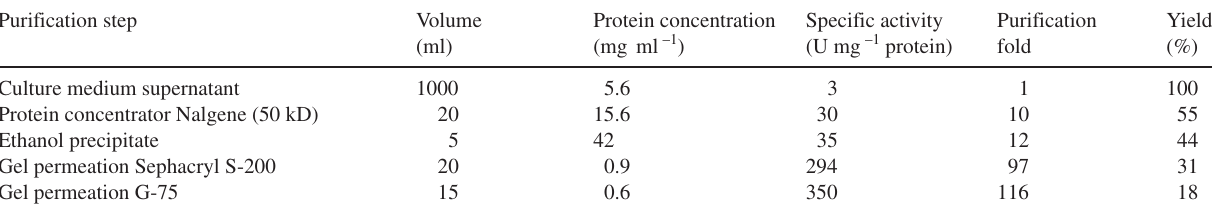
Table 1. Purification of a serine protease of Halogeometricum borinquense strain TSS101.